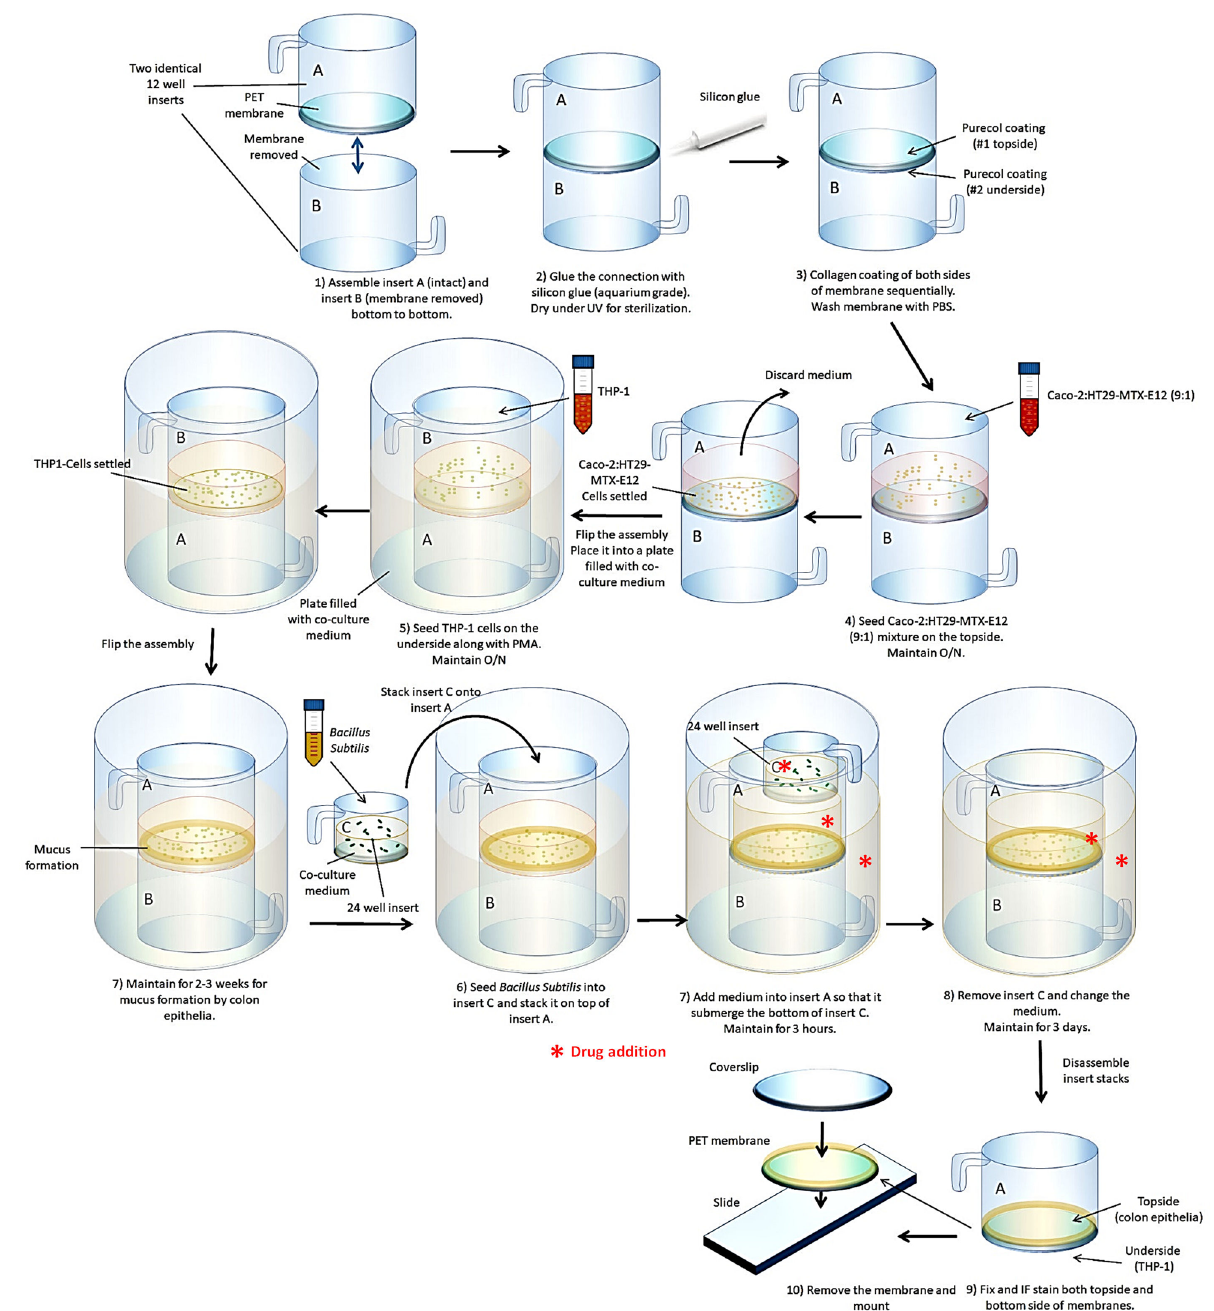
Figure 2. Schematic of the 3D Flipwell assembly and co-culture method: 3D Flipwell construction, co-culturing and analyses. Note that these steps exclude experiment specific steps of permeabilization, fixation, and immunofluorescent staining or dehydration steps for electron microscopy. Red asterisks: points of drug